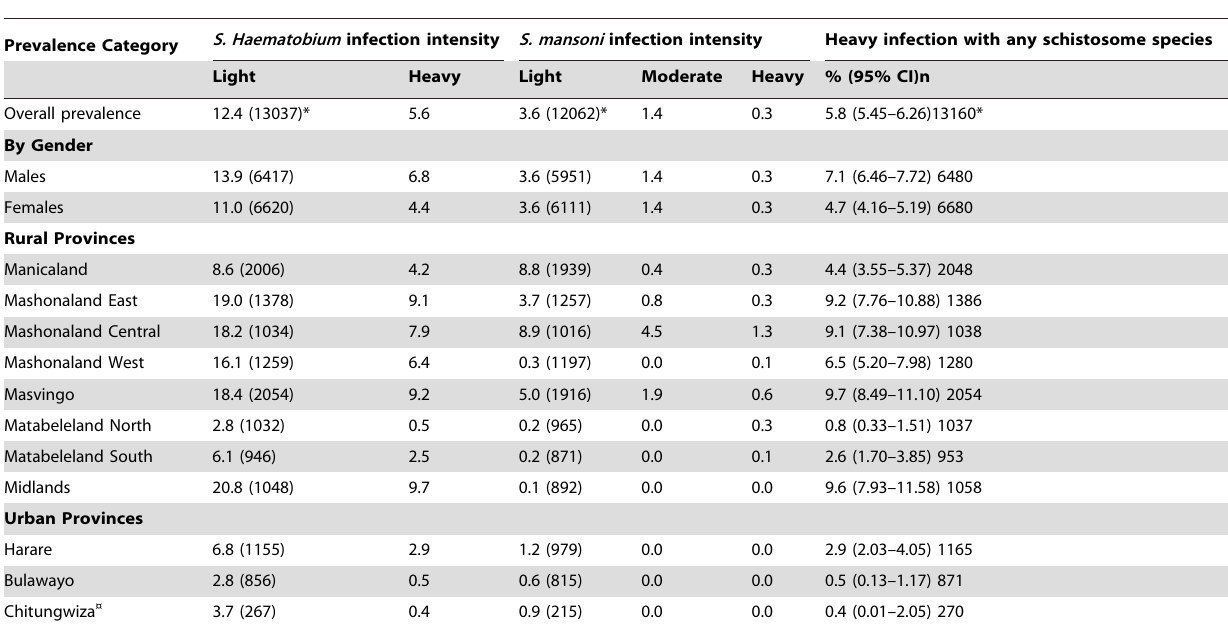
Table 3. Prevalence of infection intensities of schistosome species and heavy infection with any schistosome species in Zimbabwe stratified by gender and province in 2011.